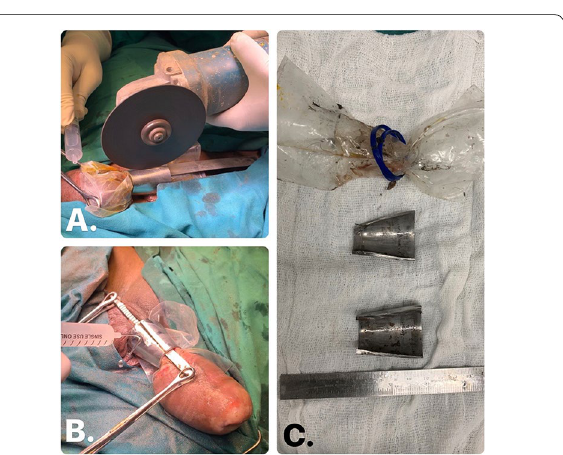
Fig. 2 Metal cone was cut using an electric drill, and a metal ruler was introduced underneath the metal cone to prevent the iatrogenic injury. a Scalpel handle and continuous cold-water irrigation used to avoid the iatrogenic injury. b Metal cone was cut at two places, 180-degree opposite to each other, and was removed in two